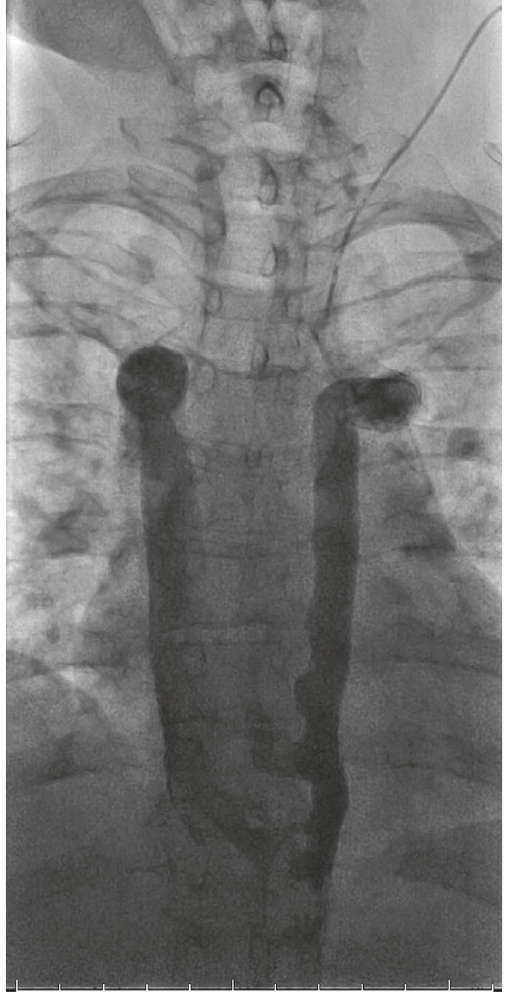
Figure4:Leftinternaljugularvenogram(latephase)demonstrating PLSVC with continuation into the hemiazygos vein. Collaterals cross midline from left to right into the azygos vein at the T8 and T9 levels with subsequent drainage into the right SVC. There is visualization of streaming of contrast outlining the lateral margin of the SVC (short arrows) and right atrium (long